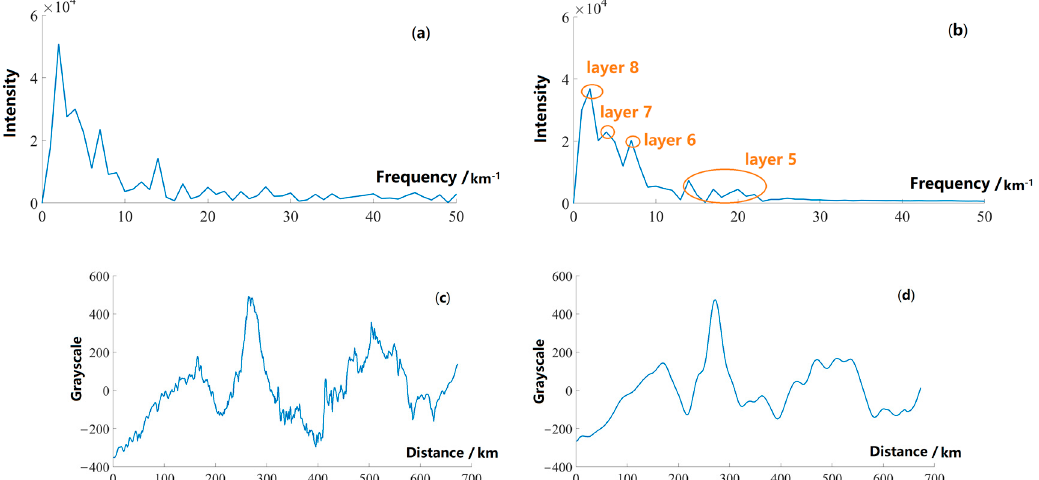
Figure 9. Comparison before and after denoising. ( a , b ) The spectra before and after denoising, respectively. The horizontal axis is the frequency, and the vertical axis is the intensity. The intensity indicates the unnormalized proportion of the wave in the corresponding frequency band. ( c , d ) The waveforms before and after denoising, respectively. The horizontal axis is the distance from the starting point of the measuring line and the vertical axis denotes grayscale.